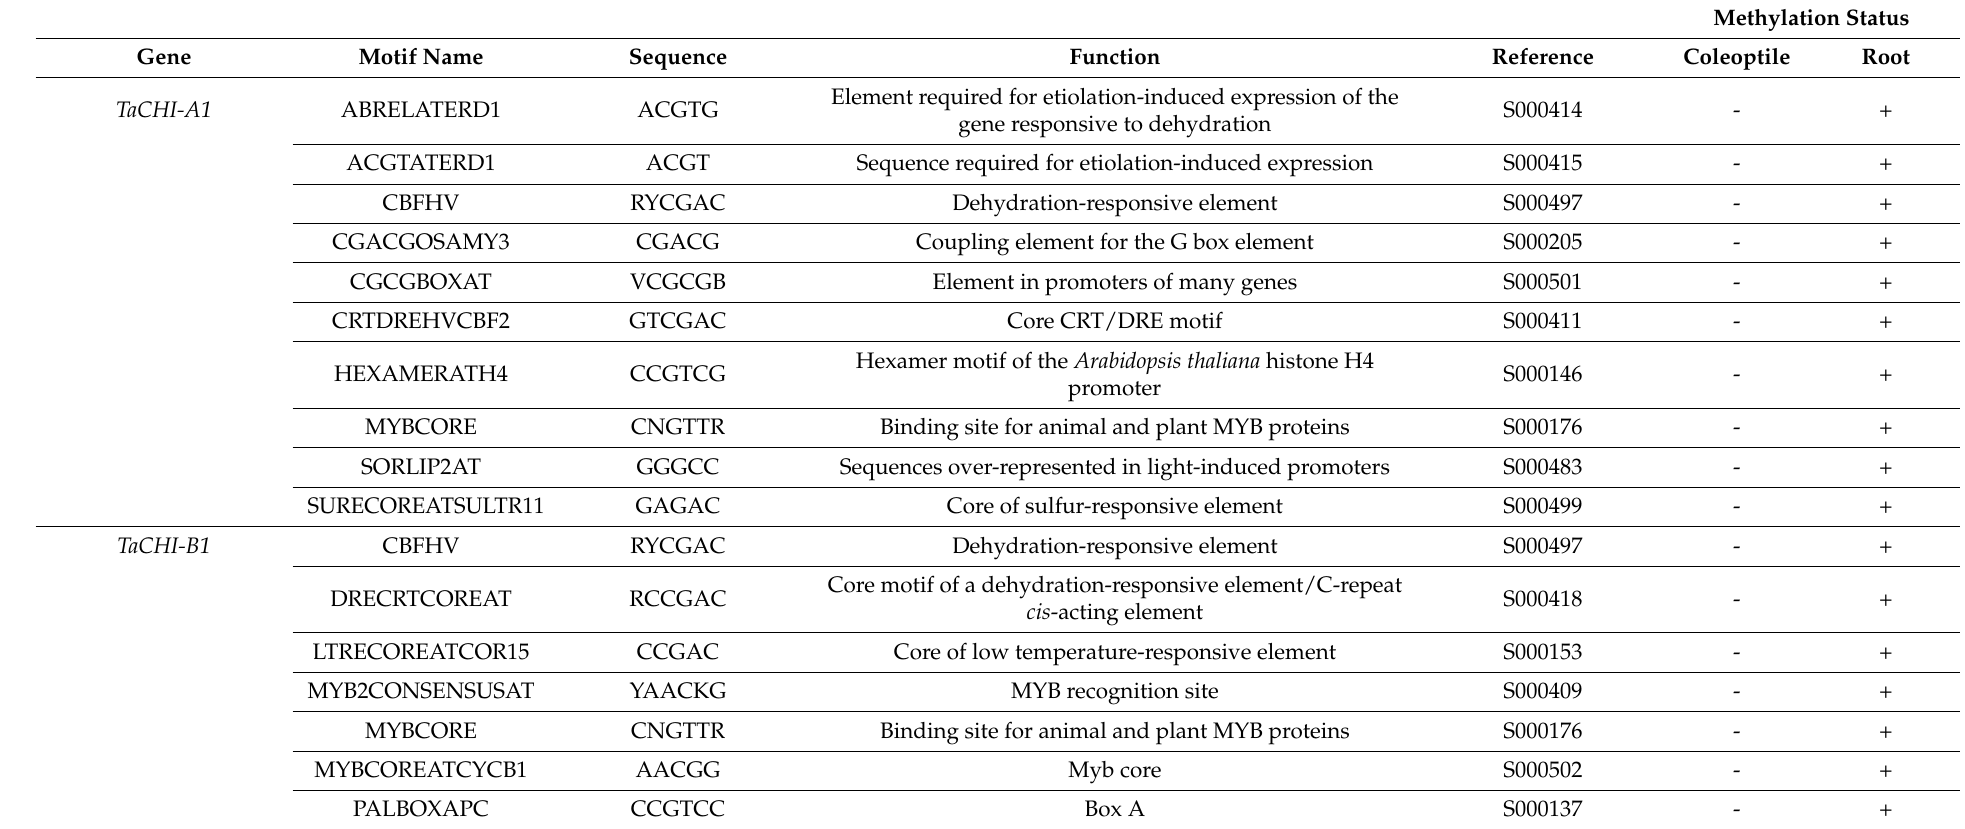
Table 3. Methylation status of regulatory motifs in the TaCHIs and TaF3Hs promoter sequences. R = A/G, Y = C/T, K = G/T, W = T/A, V = A/C/G, B = G/T/C, N =